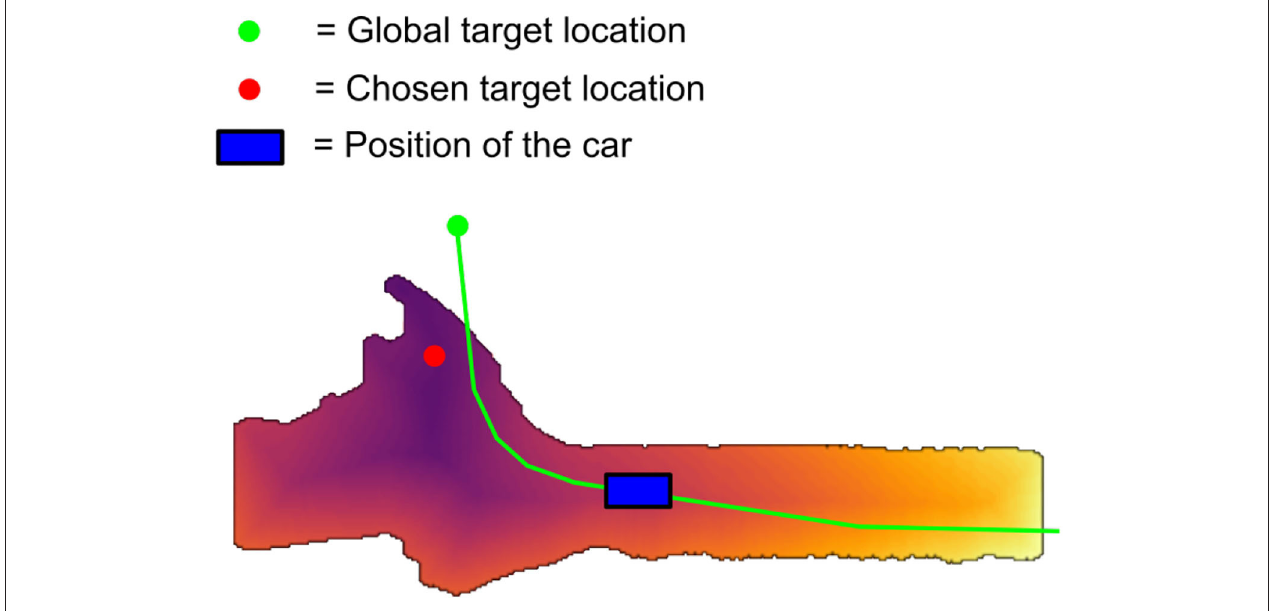
FIGURE 8 | Visualization of the costs computed by the